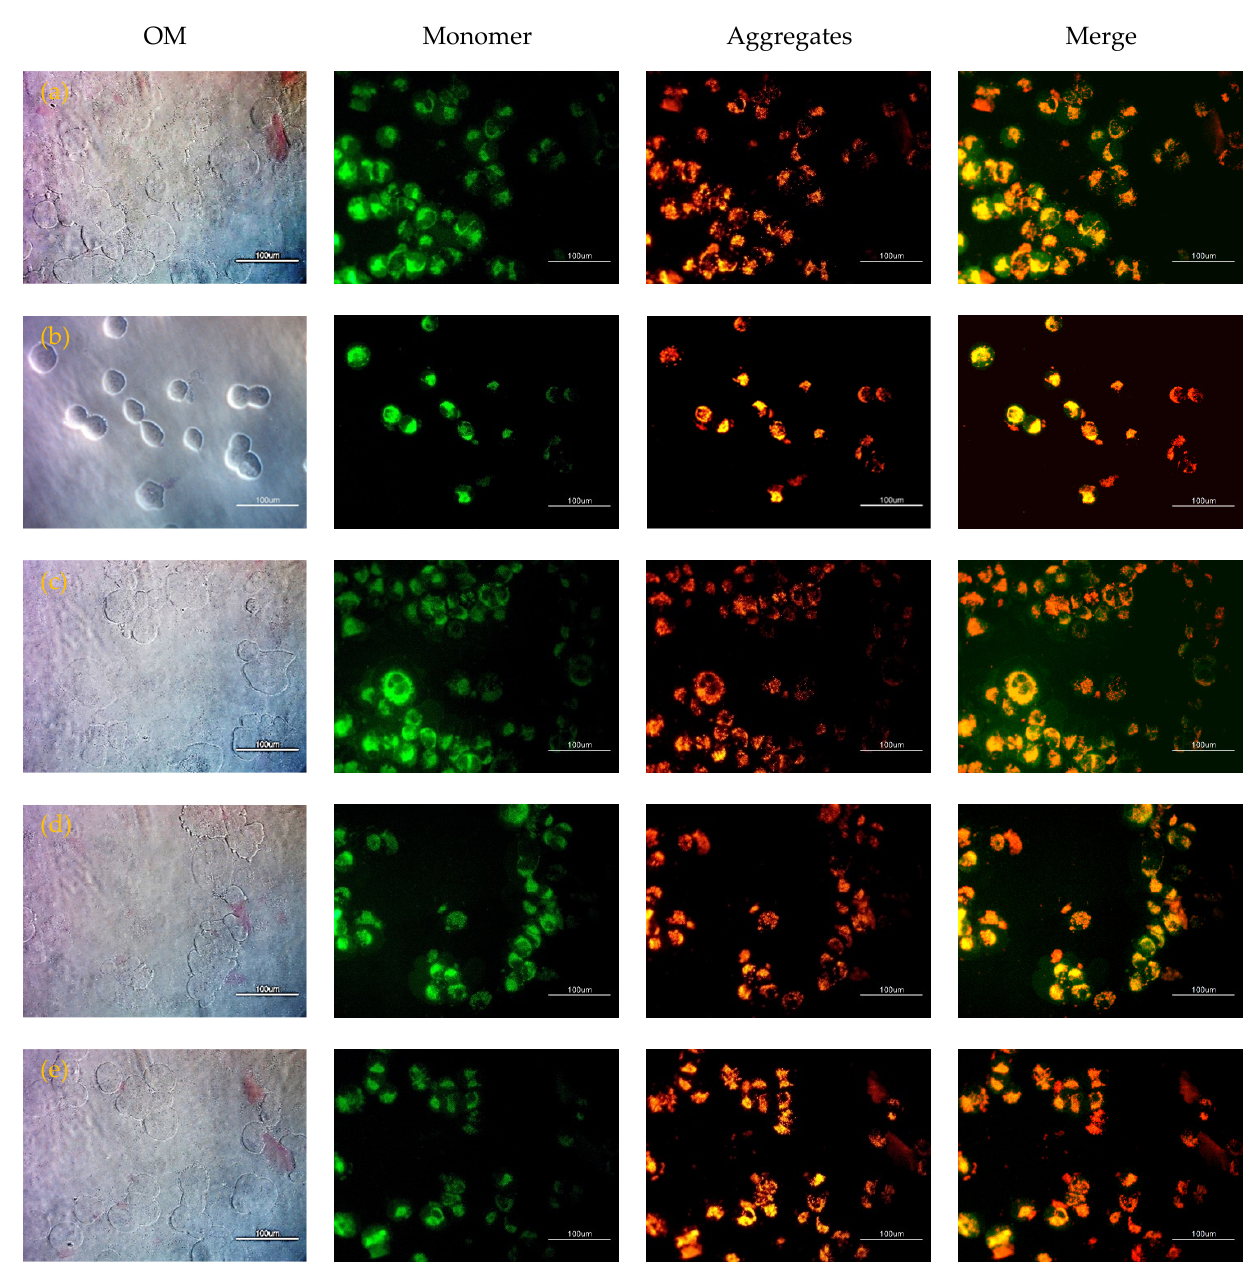
Figure 4. Optical imaging and JC-1 staining of H9c2 cells grown on various substrates: ( a ) TCPS, ( b ) silicon substrate, and ( c ) after etching, ( d ) plasma, or ( e ) scCO 2 treated. (Scale bar = 100 µ m)